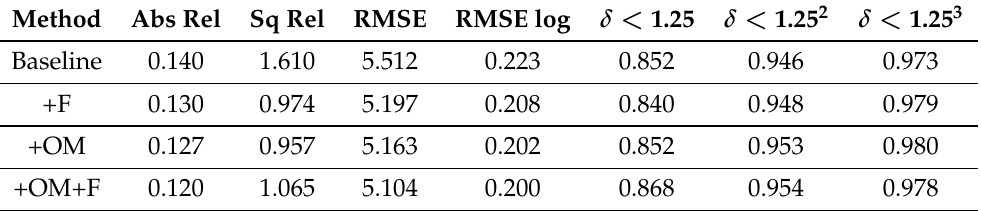
Table 4. Ablation studies on FPML and OAM. +F represents the contribution of FPML. +OM indicates the contribution of OAM. Each of our contributions improves